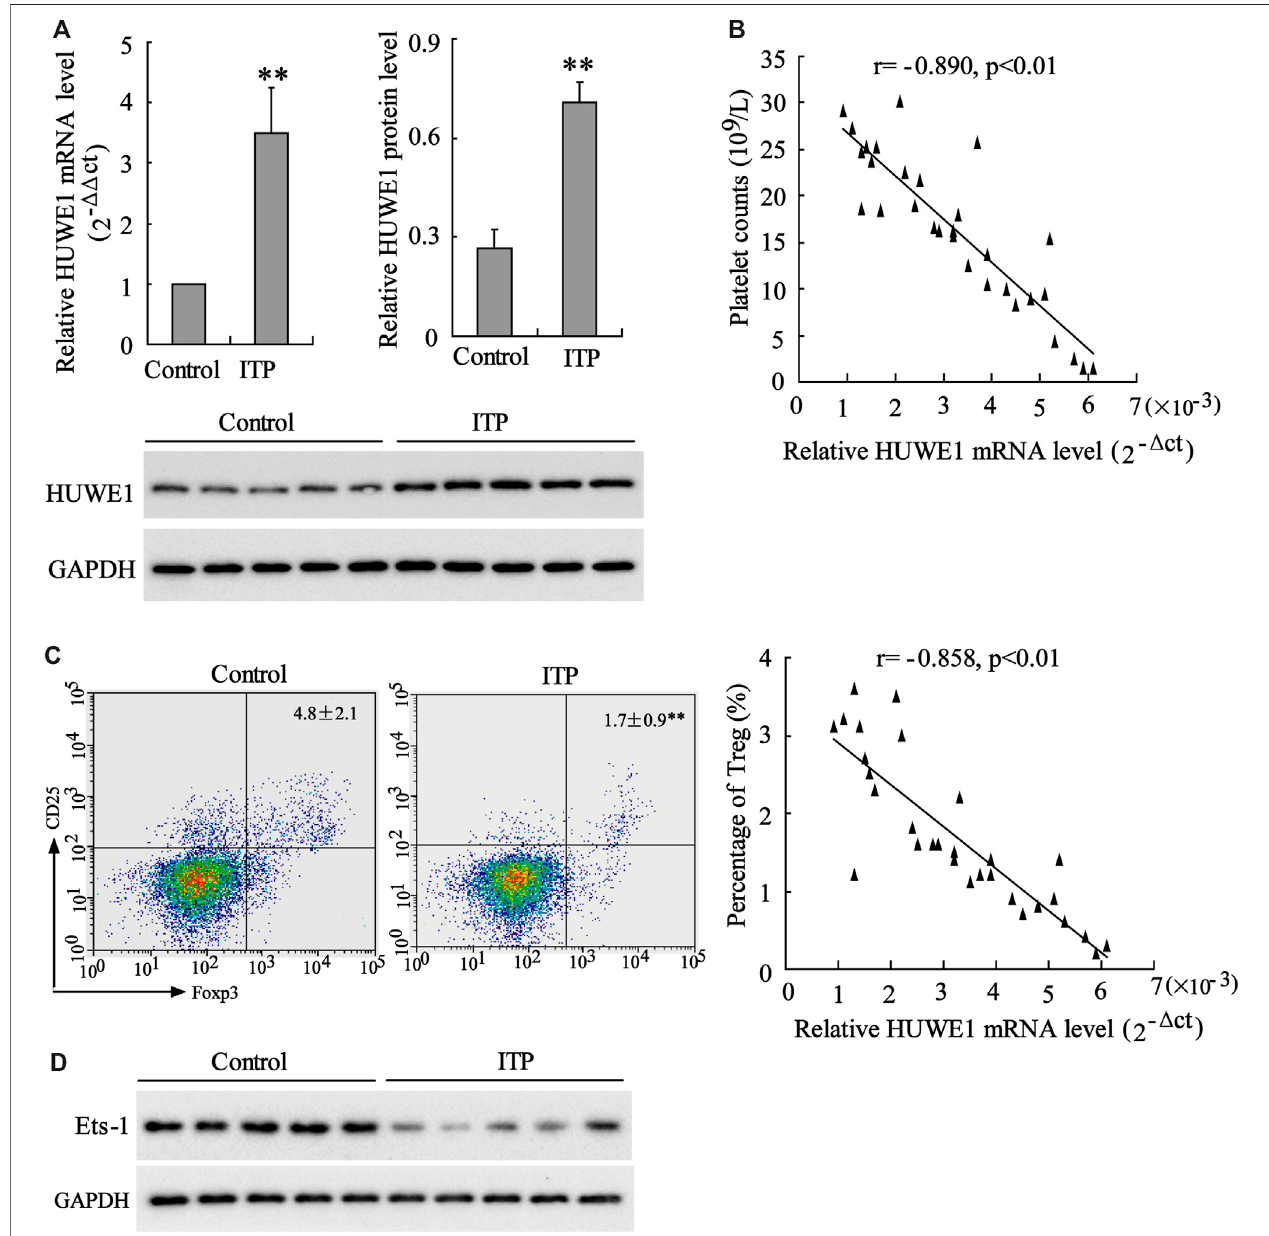
FIGURE 1 | Expression of HUWE1 in CD4 + T cells in peripheral blood from immune thrombocytopenic purpura patients. (A) Quantitative real-time PCR (qRT-PCR) and WesternblotassayswereperformedtodetectthemRNAandproteinlevelsofHUWE1inCD4 + Tcellsintheperipheralbloodfromhealthycontrolsandimmunethrombocytopenic purpura(ITP)patients;andthequantitativeanalysisofHUWE1proteinlevel(mean ± SEM, n (cid:2) 5). (B) CorrelationanalysisofthemRNAlevelofHUWE1andplateletcountsinCD4 + T cells in the peripheral blood from ITP patients ( r (cid:2) − 0.890, p < 0.01), n (cid:2) 30. (C) Flow cytometry was applied to analyze the percentage of Treg cells in CD4 + T cells in peripheralbloodfromITPpatientsandcorrelationanalysisofthemRNAlevelofHUWE1andthepercentageofTregcellsinCD4 + TcellsinperipheralbloodfromITPpatients( r (cid:2) − 0.858, p < 0.01), n (cid:2) 30. (D) Western blot was performed to assess the Ets-1 protein level in the CD4 + T cells in the peripheral blood from ITP patients. The experiment was repeated three times. GAPDH is applied as the loading control. ** p < 0.01 vs. control. ITP, immune thrombocytopenic purpura.